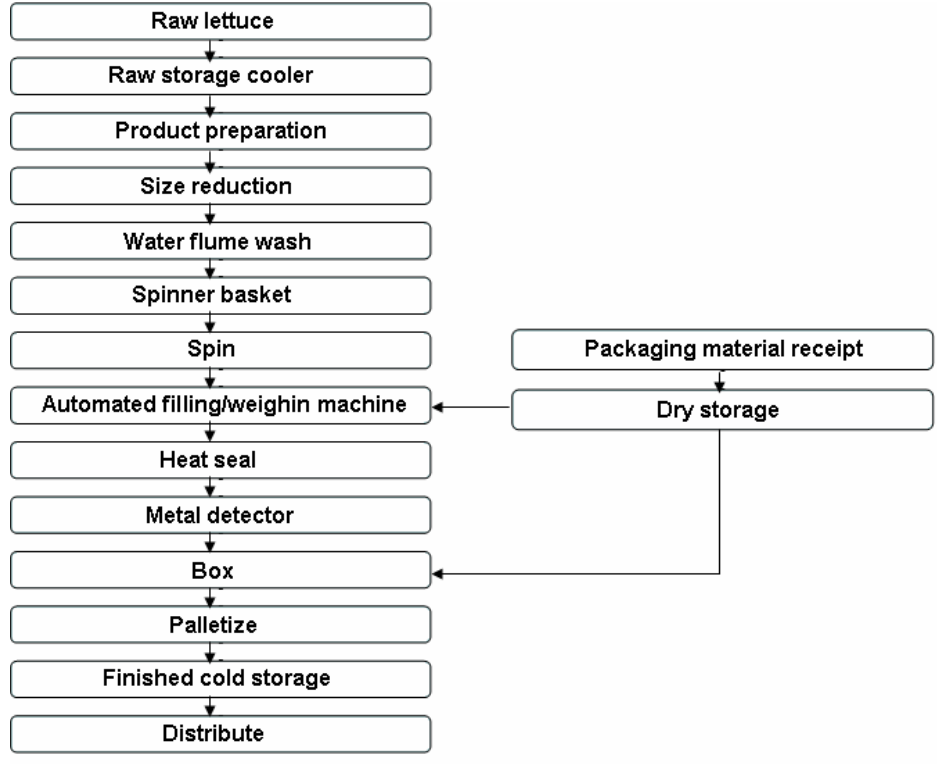
Figure 1. Example of fresh-cut lettuce